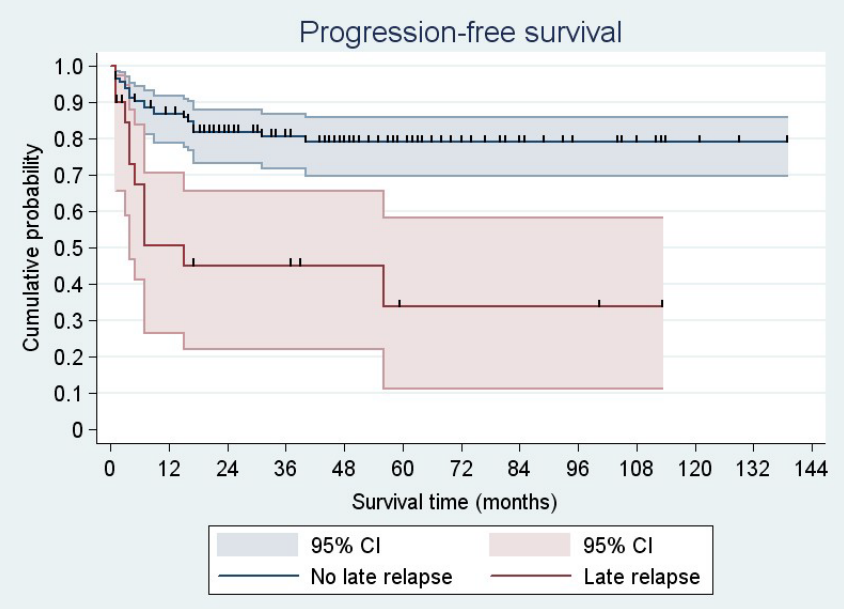
Supplementary figure 8 Kaplan-Meier analysis of progression-free survival after stratification for late